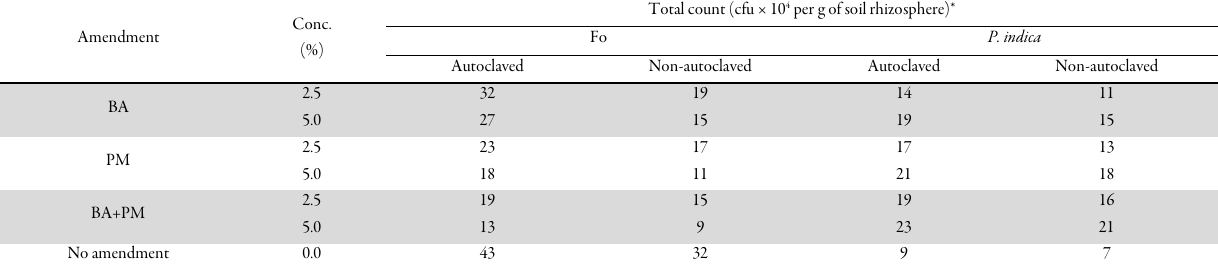
Table 8. Effect of soil amendment with organic wastes on populations of Fo and P. indica in the rhizosphere of cucumber plants in autoclaved and non-autoclaved